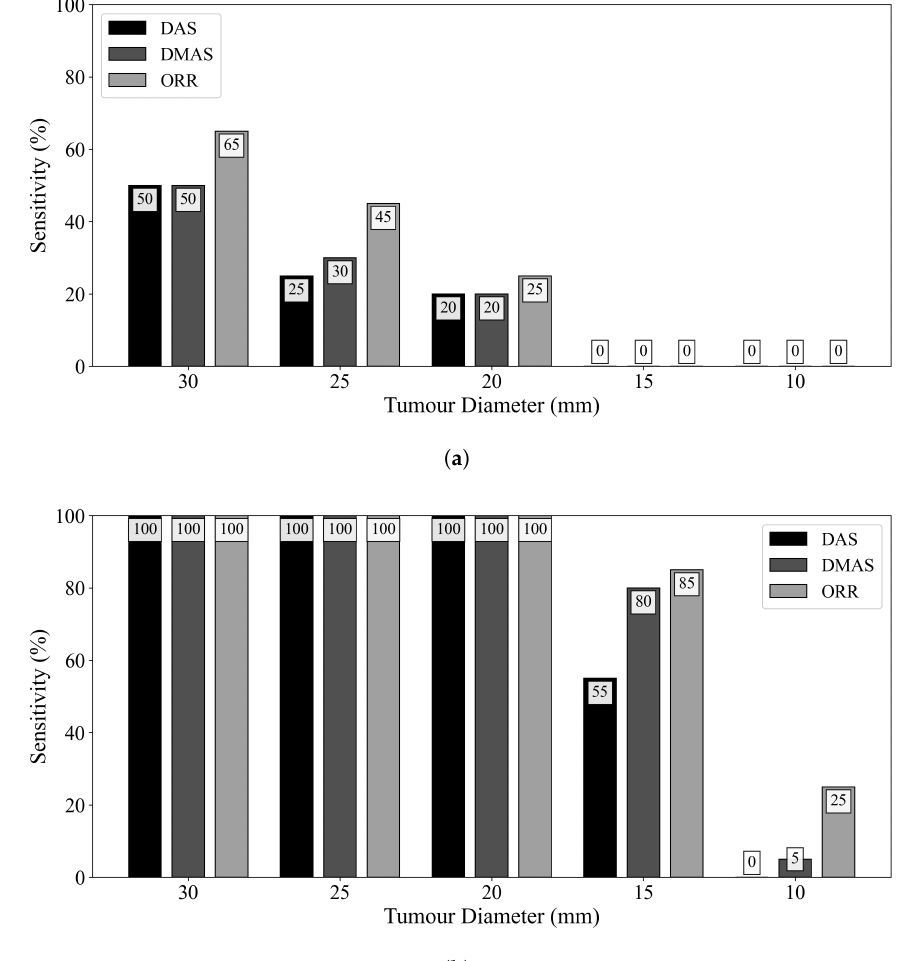
Figure 4. Sensitivity of the DAS, DMAS, and ORR reconstruction methods as a function of tumour size, evaluated on UM-BMID Gen-3 when ( a ) the adipose-only scan is used as the reference and ( b ) when the adipose-fibroglandular scan is used as the